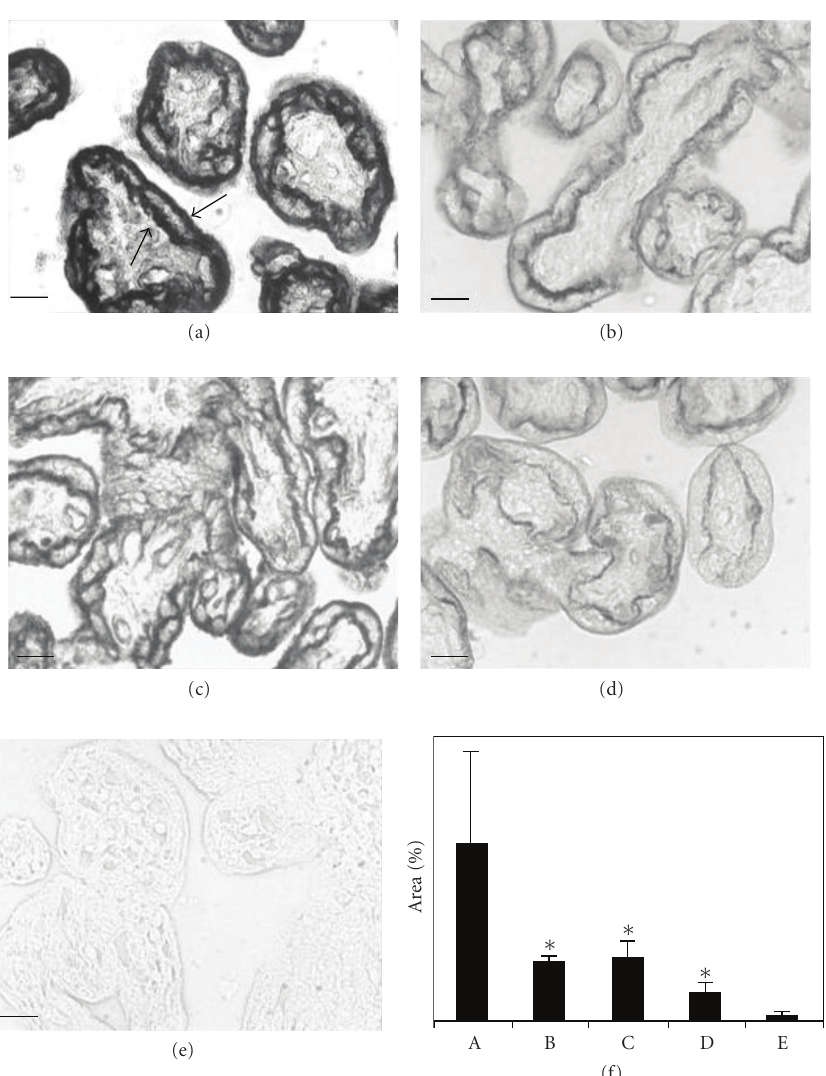
Figure 2: GLUT1 immunodetection in para ffi n-embedded placental villi sections cultured for 24 hours. (a) Uninfected control placental villi. GLUT1 expression was intensively marked on the apical and basal syncytiotrophoblast cell membrane (arrows); (b) normal placental villi in vitro infected with T. cruzi ; (c) normal placental villi cultured under high glucose concentration media; (d) normal placental villi cultured under high glucose concentration media, and in vitro infected with T. cruzi ; (e) negative control placental villi (without GLUT1 antiserum incubation); (f) image quantification made by “Image Tool” UTHSCSA version 3.00, which indicates the percentage of the marked area; values shown are the mean ± SE of four samples from representative experiments (A: control placental villi, without infection; B: infected normal placental villi; C: normal placental villi cultured under high glucose media; D: infected normal placental villi cultured under high glucose media; E: negative control placental villi). Original magnification: 400x. The scale bar represents 1 µ m. ∗ Significantly di ff erent from the control placental villi ( P < 0 . 05; n = 4; paired t